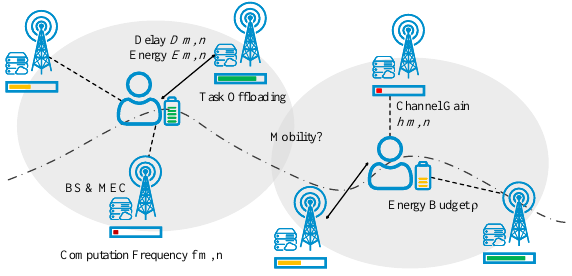
Figure 2. System model of mobility-aware task offloading in MEC enabled 5G